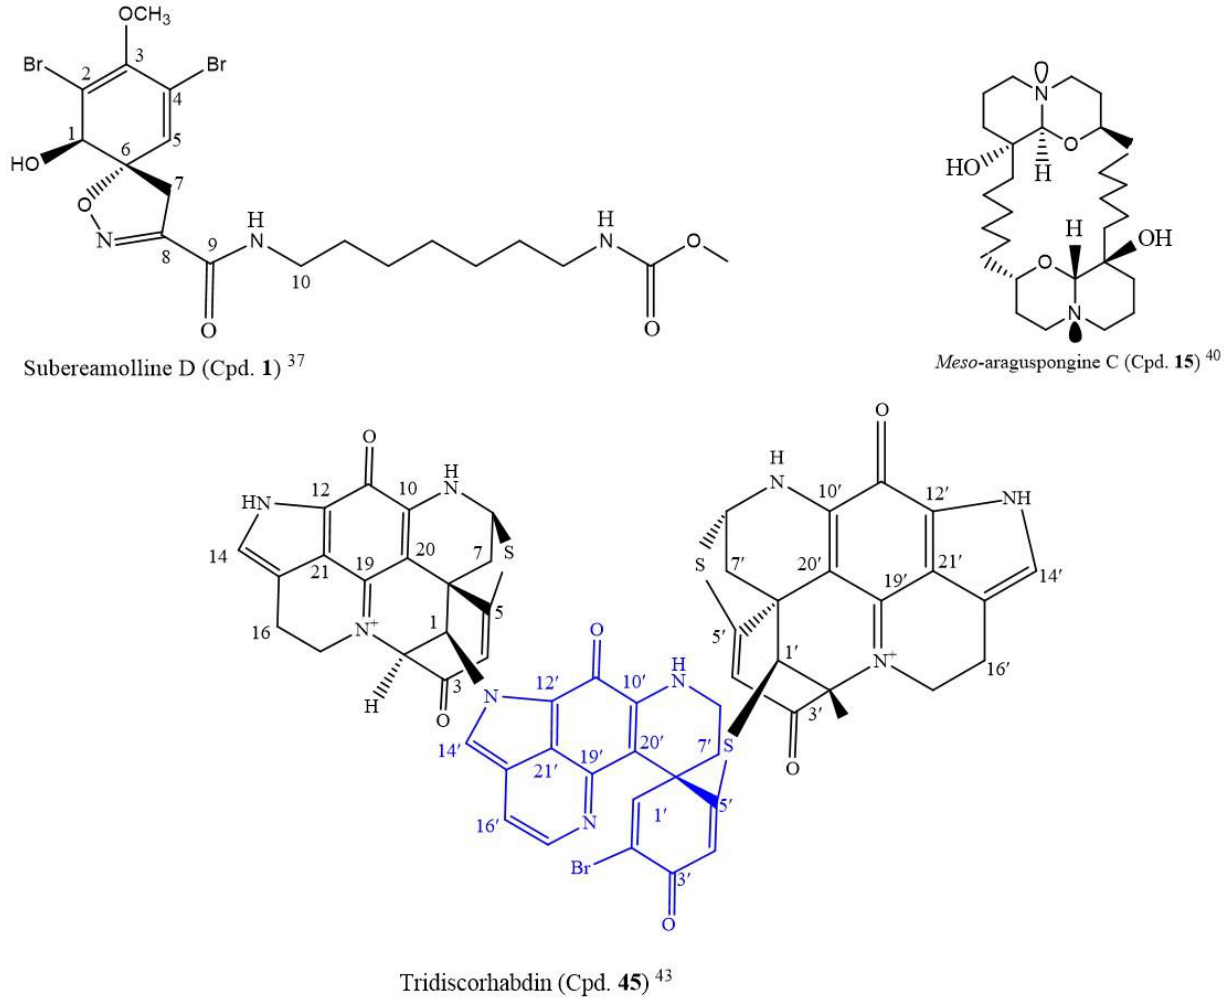
Figure 1. The structures of novel marine-derived alkaloid compounds cytotoxic to cancer cell lines at IC 50 ≤ 1.0 µM .